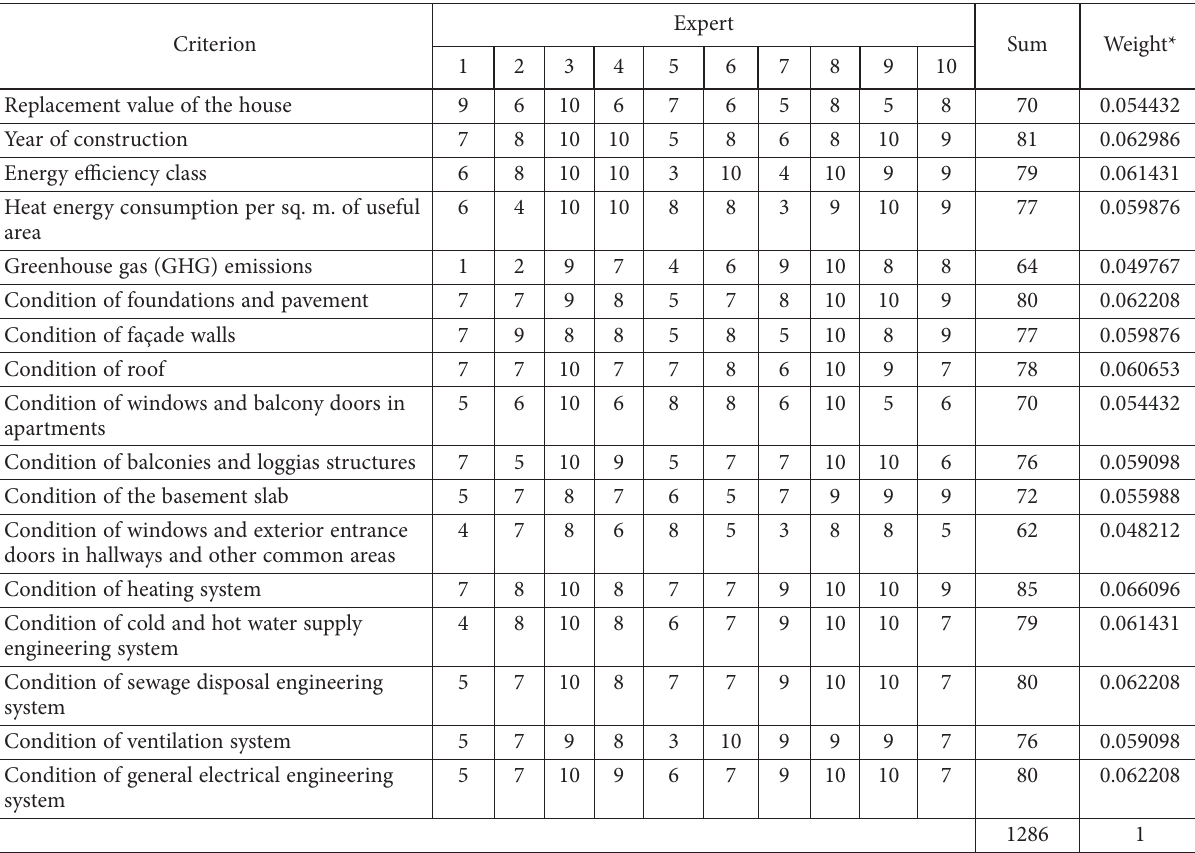
Table 2. Estimation of criteria